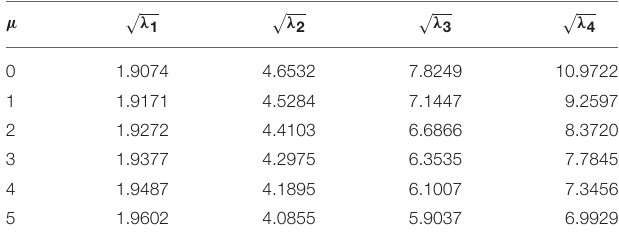
for CF case for different nonlocal (cid:17)